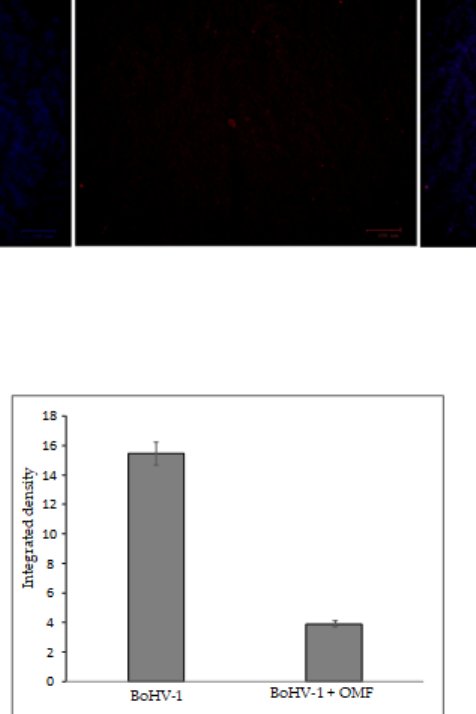
Figure 6. OMF reduces the expression of bICP0 during BoHV-1 infection in MDBK cells. ( A ) Cells were infected with BoHV-1, at an MOI of 0.1, in the presence or absence of OMF, and after 24 h p.i., immunofluorescence staining for bICP0 (red fluorescence) was performed as described in the Methods section. Nuclei were counterstained with DAPI. During infection, bICP0 was localized in both the nucleus and cytoplasm. In the presence of OMF, the expression of bICP0 was noticeably reduced during BoHV-1 infection. Scale bar 100 µm. ( B ) Bars represent the mean ratio generated from the integrated density (product of the area and mean intensity of fluorescence) of the bICP0 expression evaluated by ImageJ. Error bars represent standard error measurement.